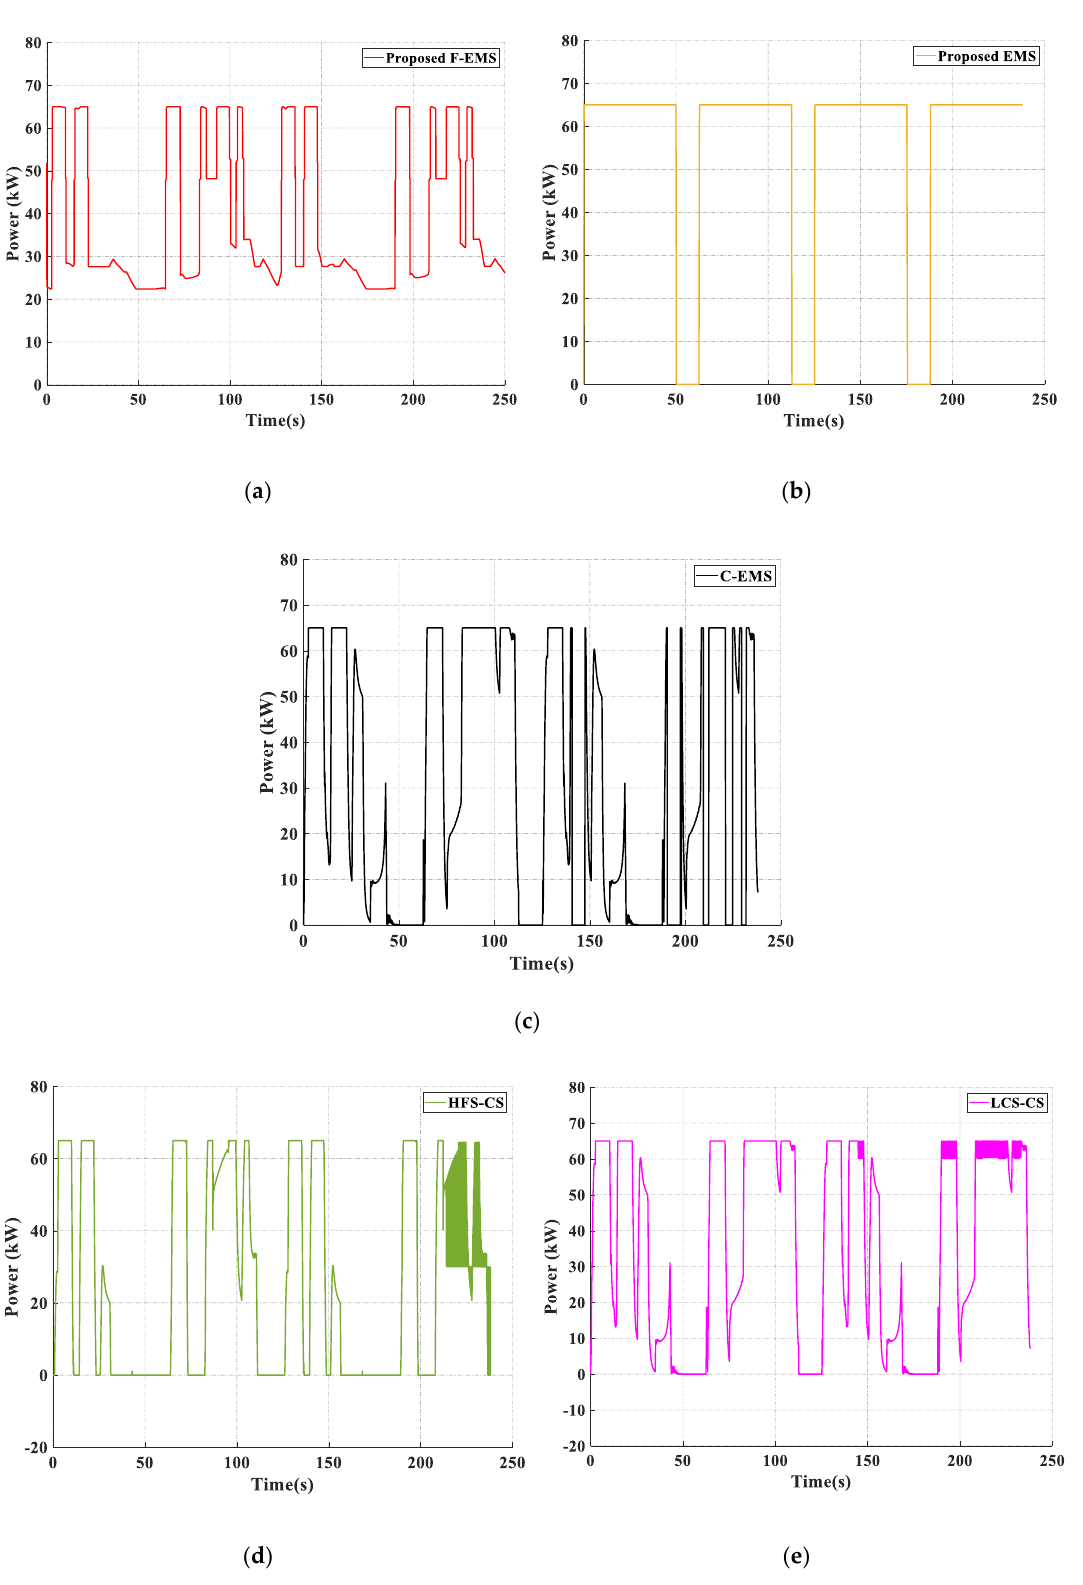
Figure 12. Power released from the FC for the five strategies: ( a ) proposed F–EMS, ( b ) proposed EMS, ( c ) conventional EMS (C–EMS), ( d ) HFS–CS, and ( e ) LCS–CS.